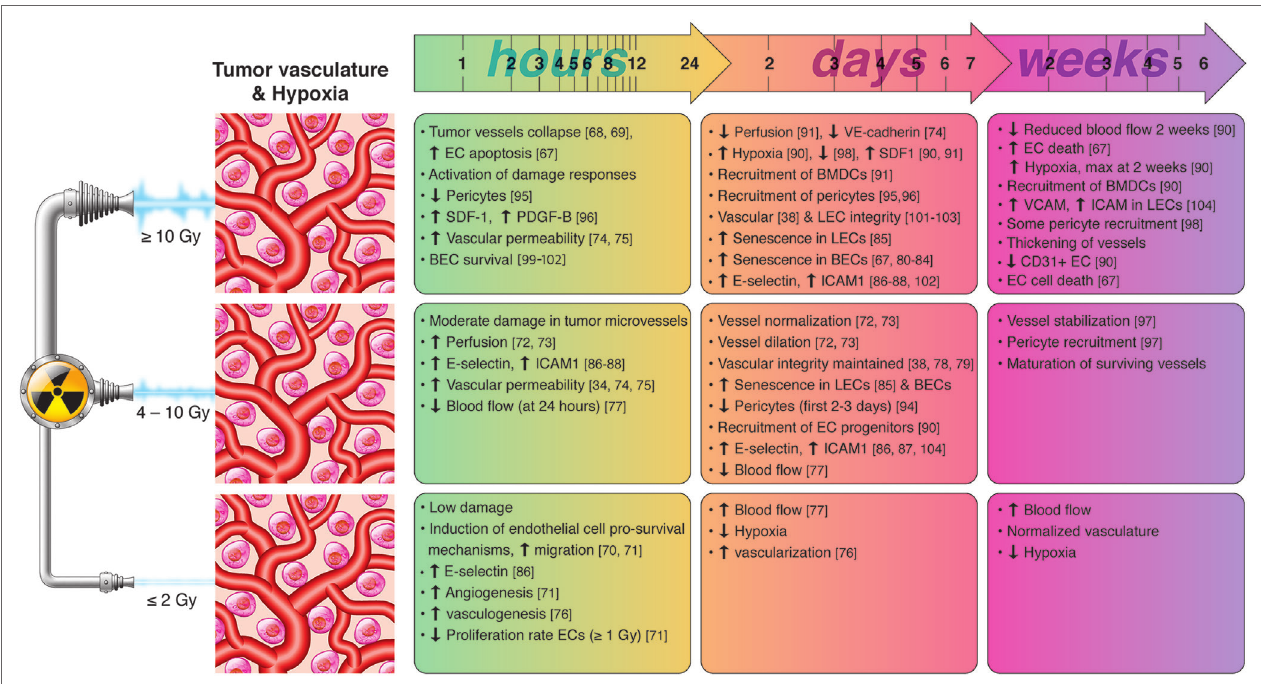
FiGURe 2 | Chronological effects observed on tumor vasculature and hypoxia after RT delivered at different dose per fraction. The figure is a compilation of observations registered in different experimental models, comprising cell cultures (in vitro), animal (mainly mice) models, and clinical observations, on effects of RT given at different dose/fraction. Radiation schemes range from single fractions to oligo (daily) fractions and prolonged multifractionated regimens. The vast majority of preclinical observations comprise RT regimens of one or few fractions irrespective of the radiation dose. In clinical settings, RT protocols comprising moderate or high doses are always applied in one or few fractions. Although some inconsistencies may exist between studies, it is generally observed that small doses in few fractions promotes endothelial cell (EC) survival and increased intratumoral blood flow, whereas high-dose RT induces EC apoptosis, hypoxia-response elements and the recruitment of EC progenitors during the first days post-RT. Medium radiation doses, given in one or few fractions, induce moderate damage in tumor blood vessels, promotes the dilation and normalization of existing vessels, pericyte recruitment, and the expression of cell adhesion molecules. Lymphatic endothelial cells (LECs) are more radioresistant than blood vessels but may enter into premature senescence already after moderate radiation